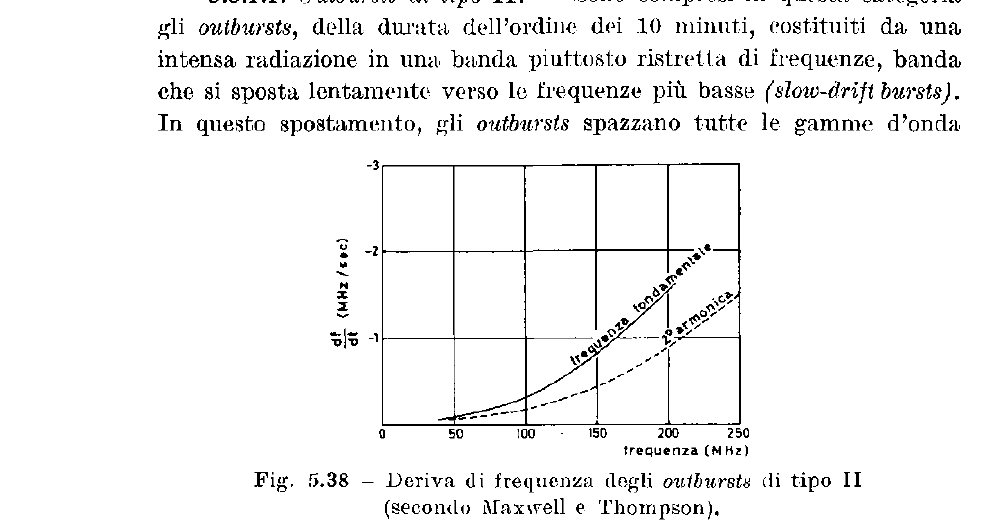
Fig. 5.38 - Deriva di frequenza degli outbursts di tipo II (secondo Maxwell e